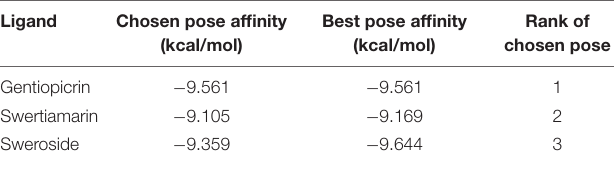
TABLE 1 | Ligand docking summary into Ce BGlu1 AlphaFold